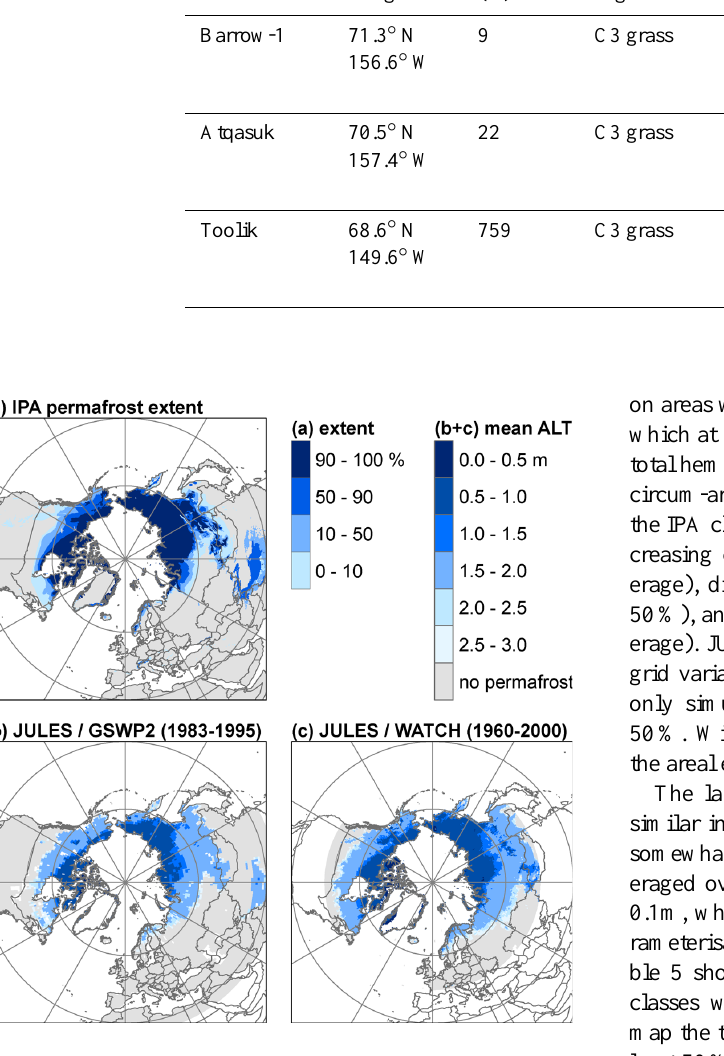
Fig. 1. (a) Observed permafrost coverage, as compiled by the Inter- national Permafrost Association (IPA) (Brown et al., 2001); (b) and (c) Areas with permafrost in the GSWP2 and WATCH runs, respec- tively, with mean active layer thickness (ALT) over the period indi-